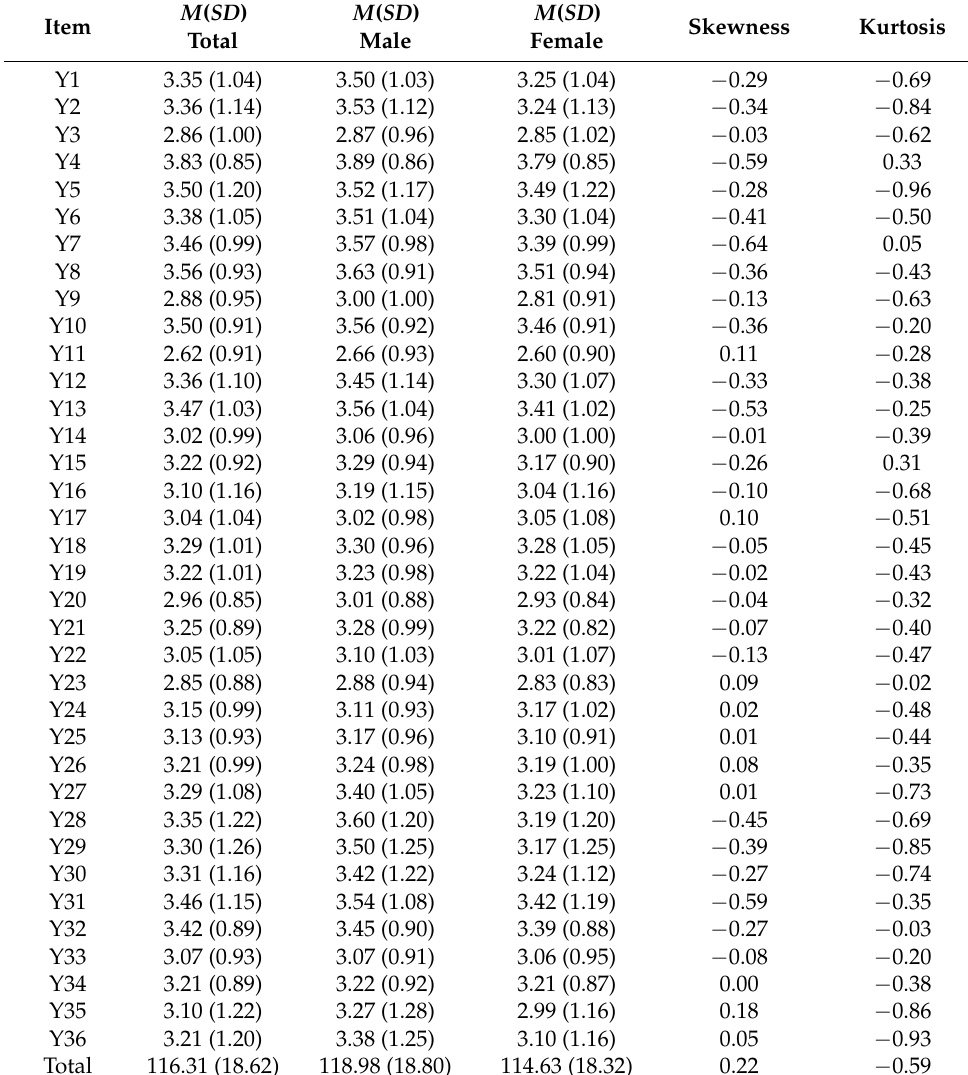
Table 2. Descriptive statistics of the DERS items ( N =